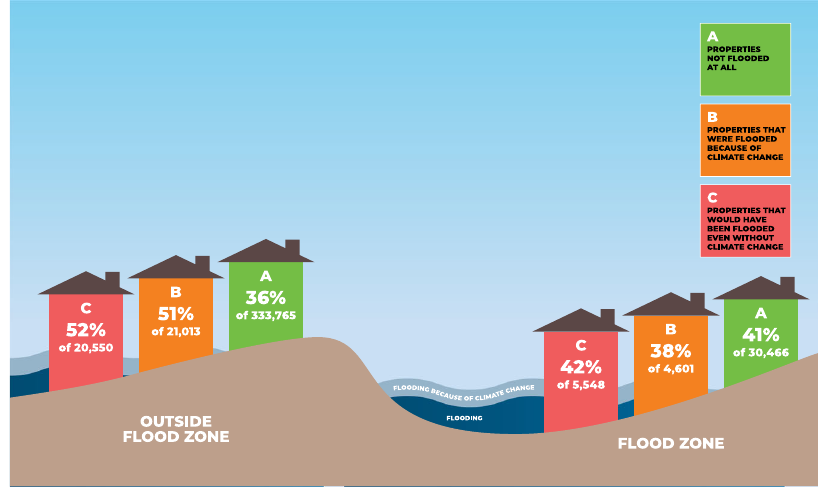
Fig. 5 Percent of Latina/x/o parcels fl ooded because of climate change inside and outside of fl oodplains (38% scenario). Estimated percentages for residential properties in Harris County, Texas during Hurricane